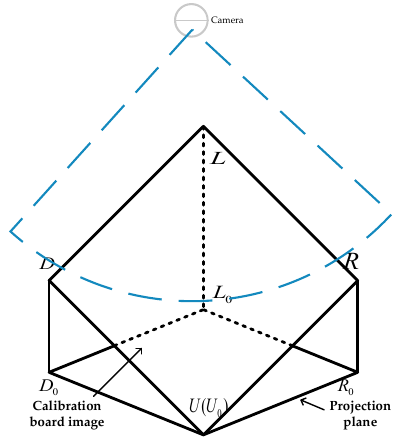
Figure 8. Spatial projection.